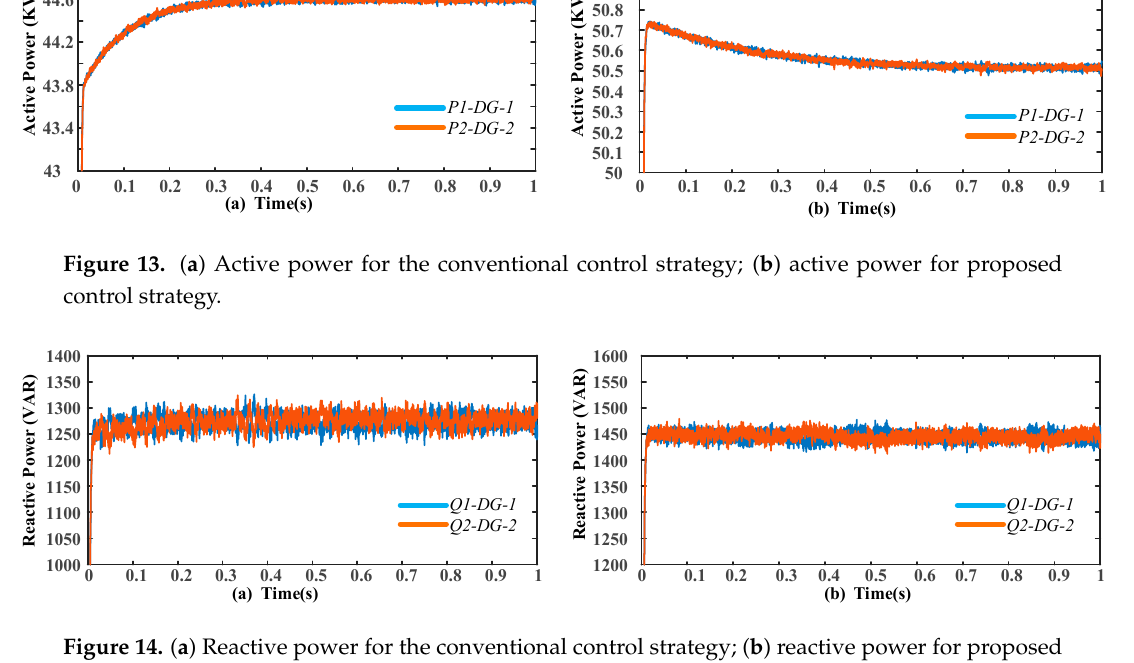
Figure 14. ( a ) Reactive power for the conventional control strategy; ( b ) reactive power for proposed control strategy.